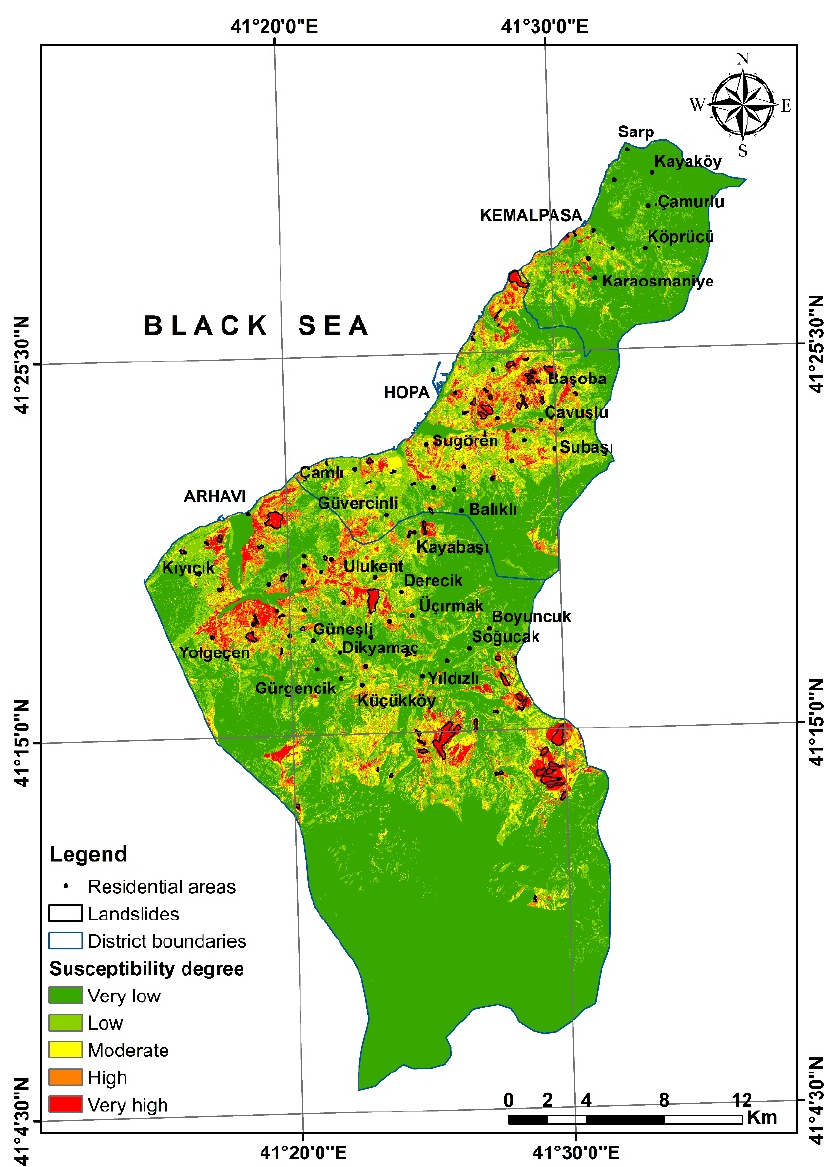
Figure 6. Landslide susceptibility map produced using the random forest model.